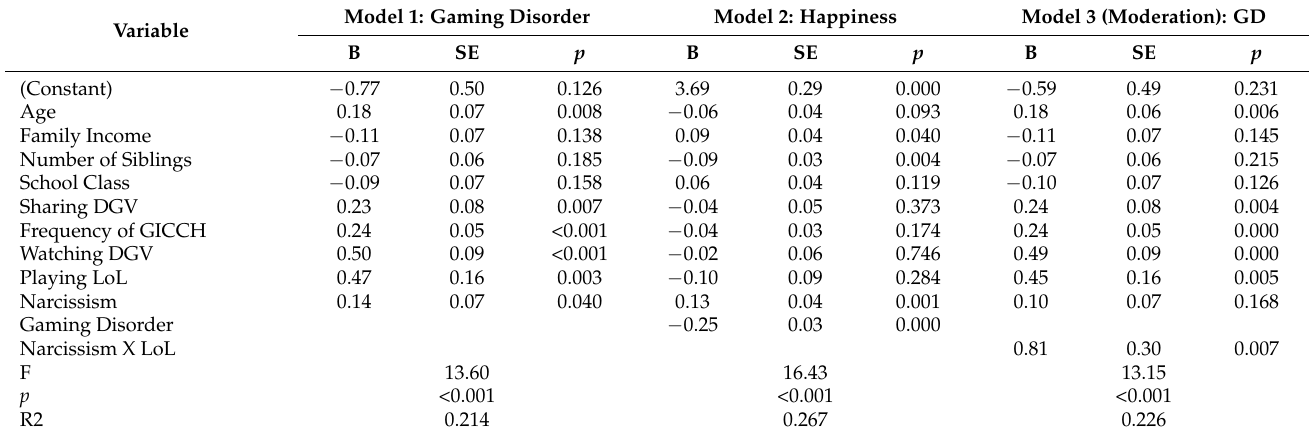
Table 4. Main effects on dependent